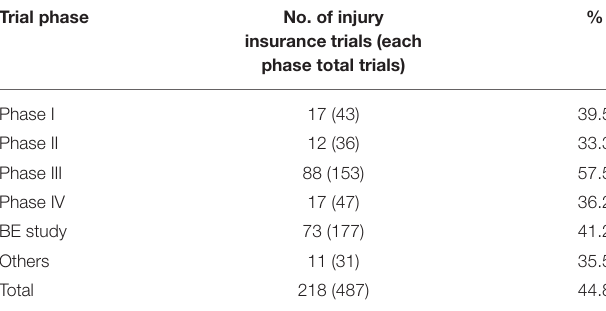
TABLE 2 | Different phase trial-related injury insurance.